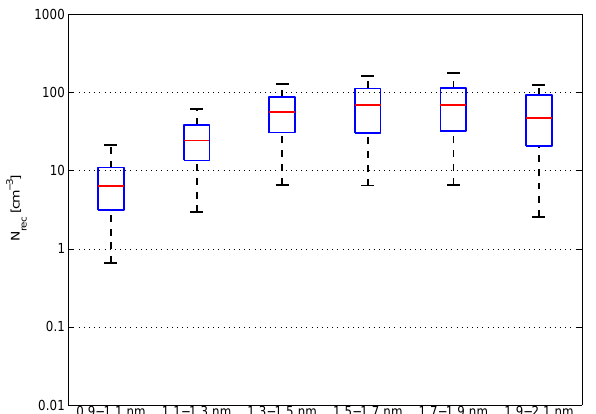
Fig. 2. The concentration of recombination products in different size classes. The red lines show the medians, the blue boxes in- dicate the 25th and 75th percentiles, and the vertical bars show the 5th and 95th percentiles.